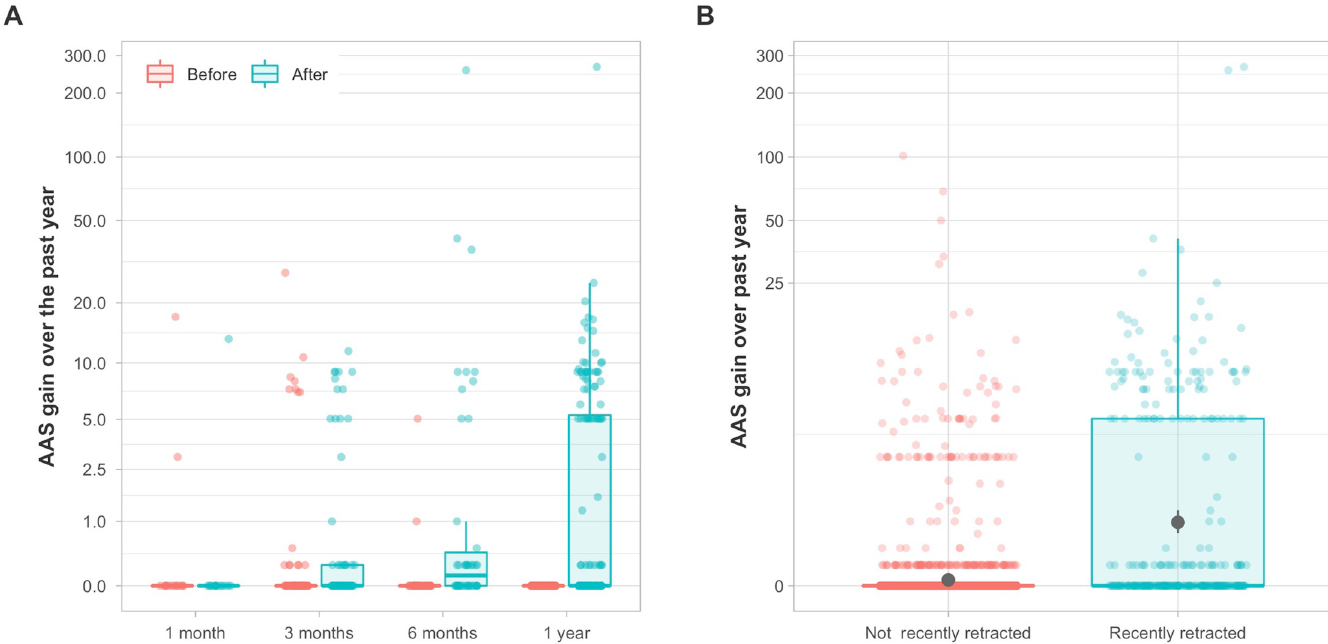
Fig 5. Altmetric Attention Score (AAS) over time. (A) Cumulative AAS for 279 articles retracted within a year of Altmetric data retrieval (from June 6, 2017 to June 6, 2018). The horizontal axis denotes how many months it has been since the article was retracted from the day of Altmetric data retrieval and the vertical axis the amount of AAS gained before and after retraction. It illustrates that, over the past year, most gains in AAS occurred after retraction. (B) Even though the median gain is zero in both 2,812 recently and 279 not recently retracted articles, proportionally many more recent articles experienced a gain, as denoted by the large interquartile range and the mean (grey dot denotes mean and range denotes the bootstrapped 95% CI).